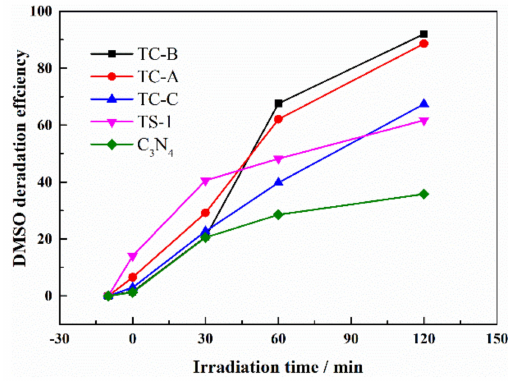
Figure 11. Time profiles of DMSO photocatalytic oxidation over all